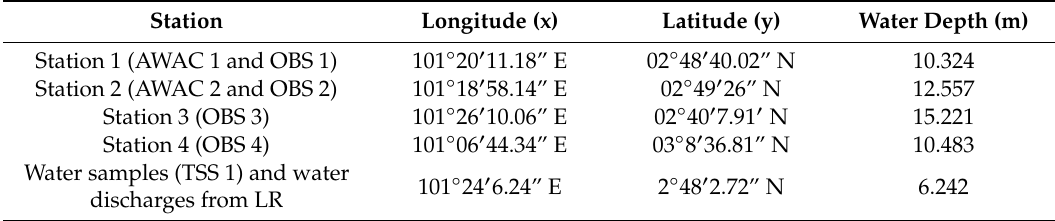
Table 2. Coordinates of field